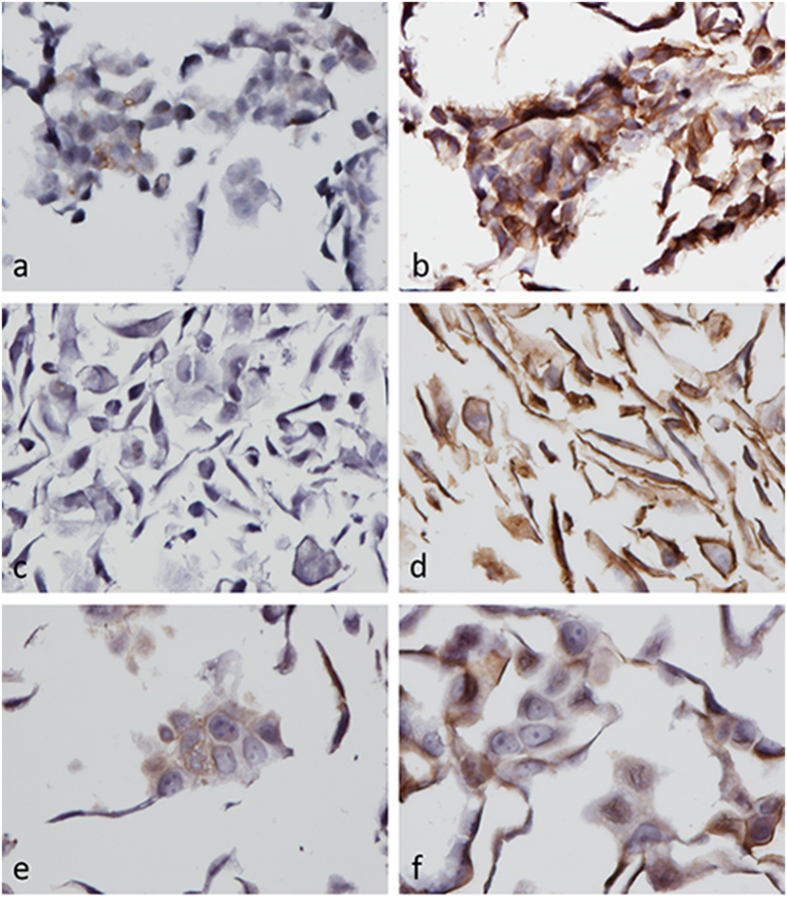
Immunostaining of ABCG2 using mAb BXP-21 (1:3000 dilution) on LoVo, MDA-MB-231, and MCF7 parental and SN-38 resistant cell lines counterstained with Mayer’s hematoxylin.ABCG2 was visualized with DAB (brown), 40x magnification. (a) LoVoparental (b) LoVoSN-38RES (c) MDADMSO (d) MDASN-38RES (e) MCF7DMSO and (f) MCF7SN-38RES.